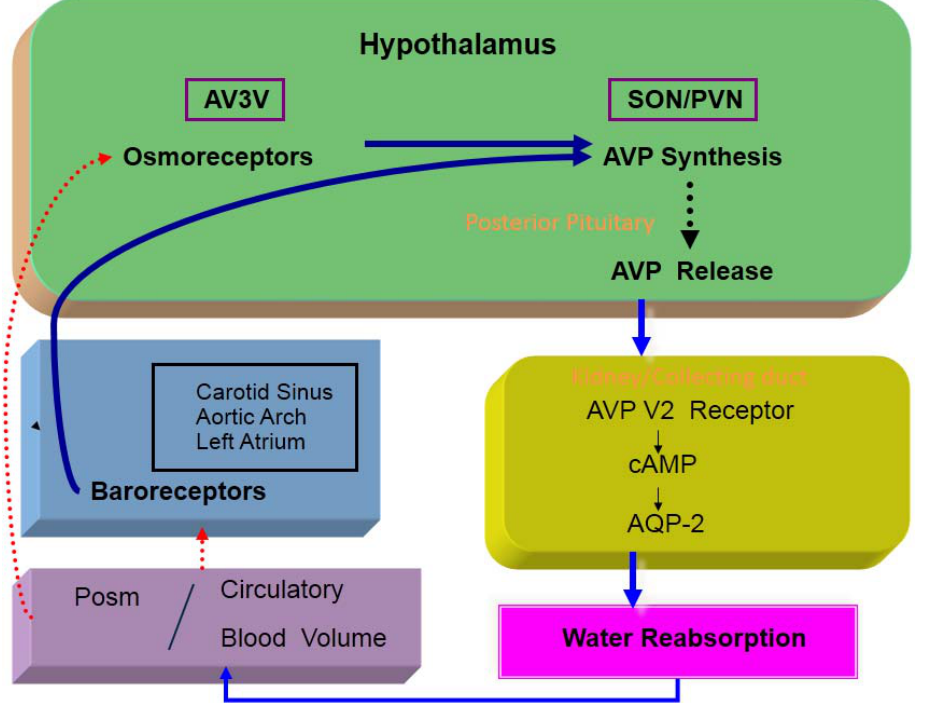
Figure 1. Osmotic and non-osmotic control of AVP